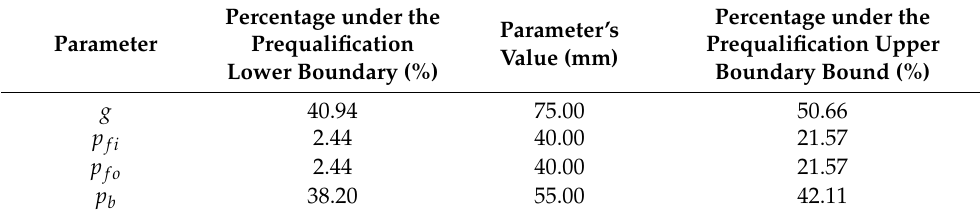
Table 9. Percentages of the dimensional noncompliance of the bolt location parameters.